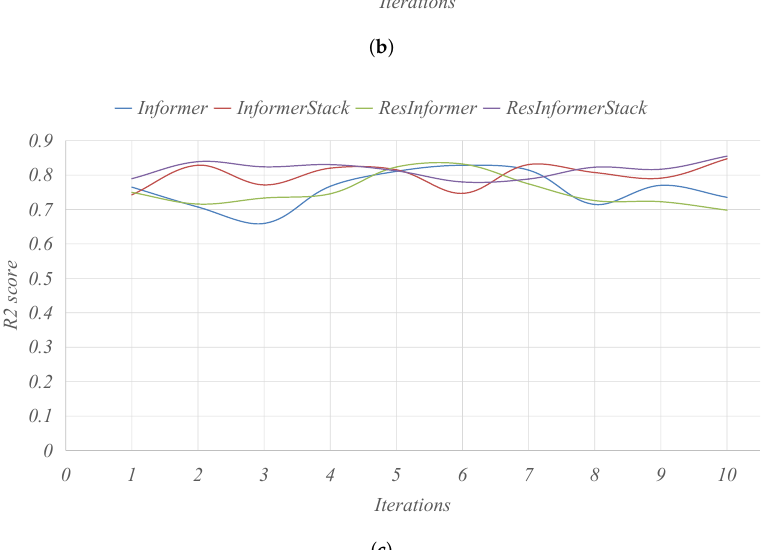
Figure 5. Beijing PM2.5 prediction scores. ( a ) MSE score for testing data predictions; ( b ) MAE score for testing data predictions; ( c ) R 2 score for testing data